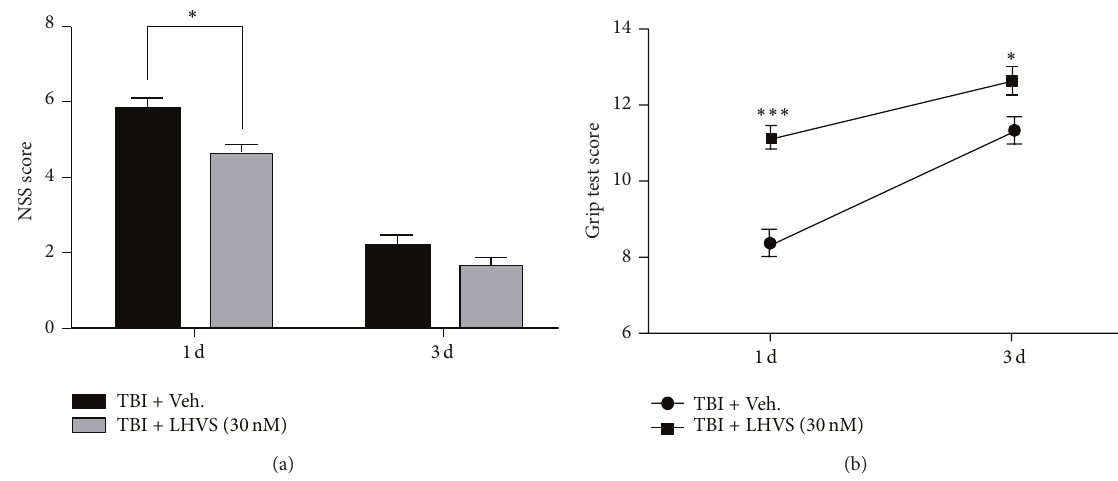
Figure 8: Neurological severity score (NSS) and grip test. (a) At 24 h after traumatic brain injury (TBI), mice pretreated with LHVS had significantly better neurological function than did mice pretreated with vehicle, as assessed by the NSS (a) and the grip test (b). At 3 days after TBI, function had improved in both groups. At this time point, neurological function was still slightly better in the LHVS-pretreated group, but the difference was significant only in the grip test. Data are presented as mean ± SEM ( 𝑛 = 6 ). ∗ 𝑃 < 0.05 , ∗∗∗ 𝑃 < 0.001 versus TBI + vehicle; two-way ANOVA followed by Bonferroni post hoc